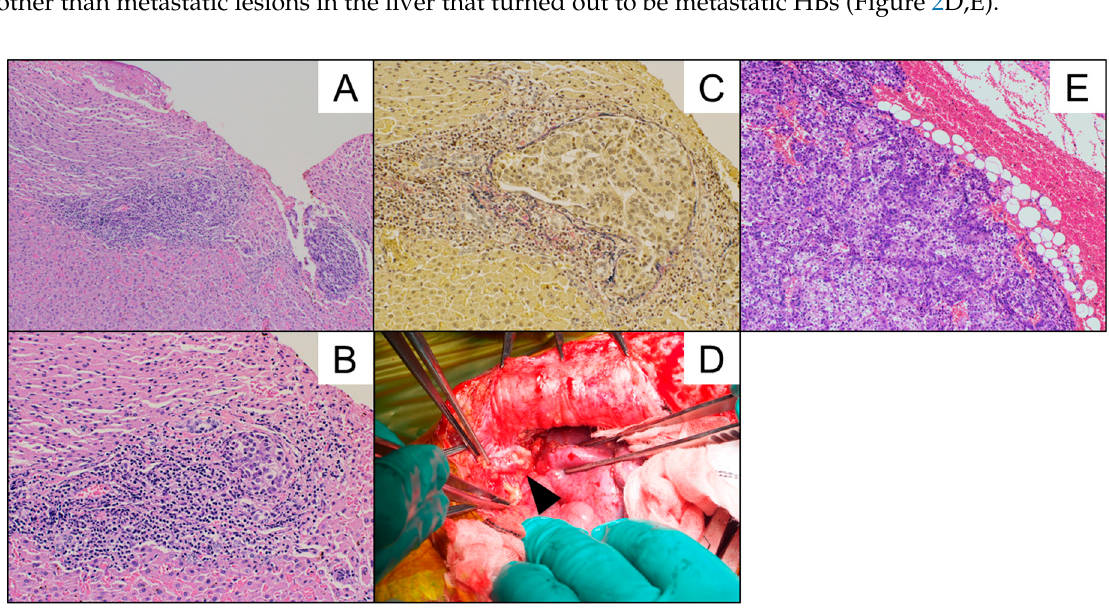
Figure 1. The clinical course of the patient. The years after the initial presentation are plotted on the horizontal axis, and the values of alpha-fetoprotein (AFP) are plotted on the vertical axis. Blue arrowheads indicate laparotomies other than living donor liver transplantation (LDLTx). Bars on the bottom represent the chemotherapeutic regimen. CITA: cisplatin 80 mg/m 2 and tetrahydropyranyl adriamycin (THP-ADR) 30 mg/m 2 , C5V: cisplatin 90 mg/m 2 , 5-fluorouracil 600 mg/m 2 and vincristine